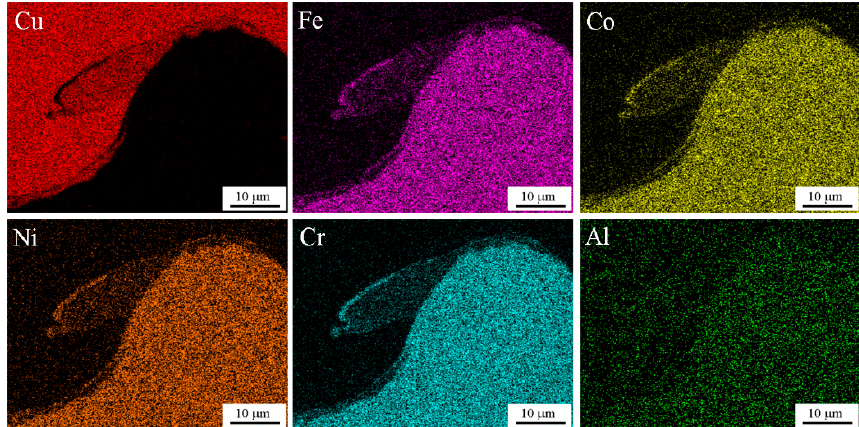
Figure 8. The element distribution corresponding to the front zone in Figure 7.